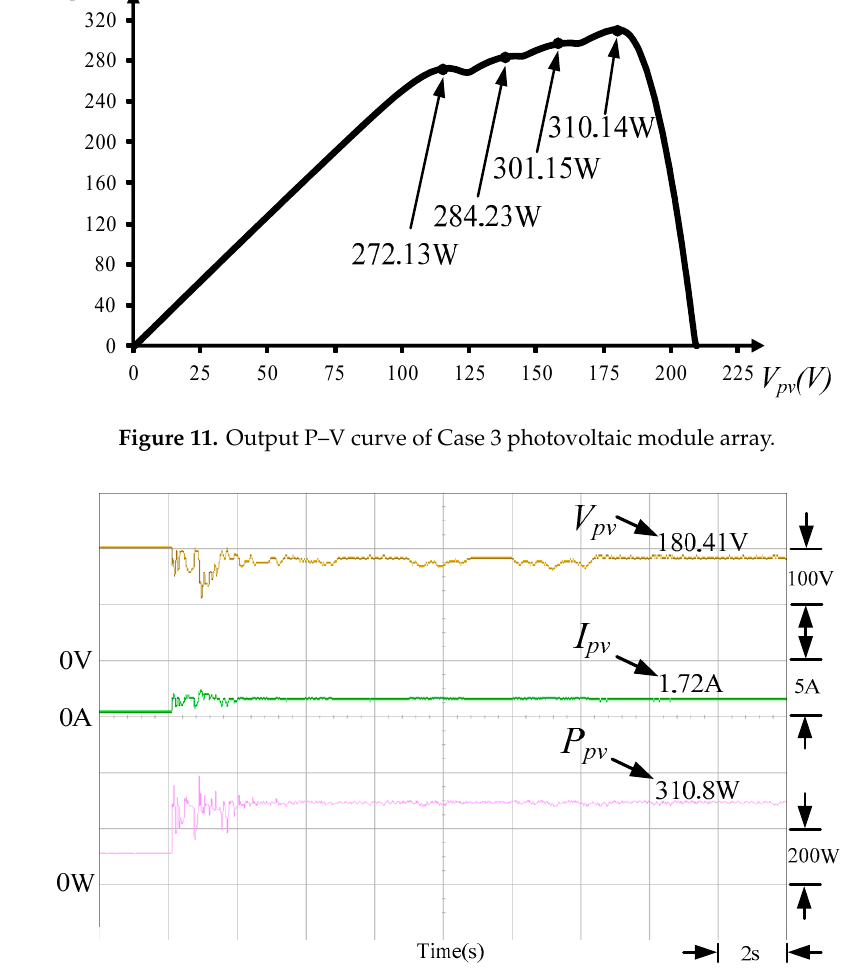
Figure 12. Case 3 measured results of maximum power point tracking by using TLBO algorithm. (4) Case 4 (10 panels in 4 parallel string arrays): [1 panel, 20% shaded + 9 panels, 0% shaded] // [1 panel, 20% shaded + 9 panels, 0% shaded] // [1 panel, 20% shaded + 9 panels, 0% shaded] // [1 panel, 20% shaded + 9 panels, 0% shaded]